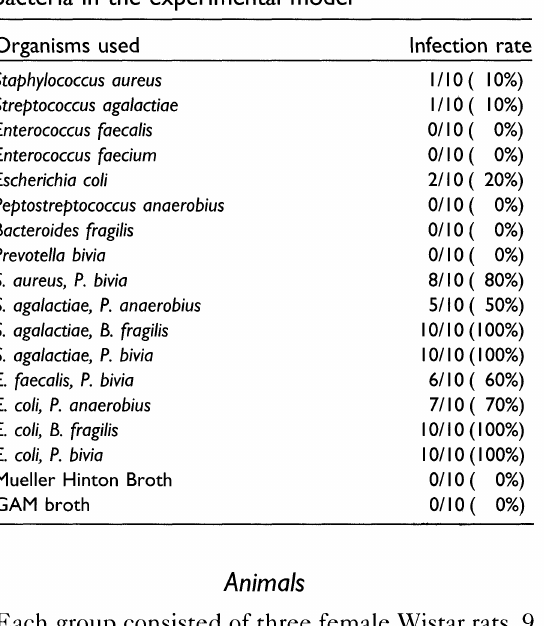
TABLE 2. Therapeutic effects of flomoxef (FMOX) on pyometra in a rat